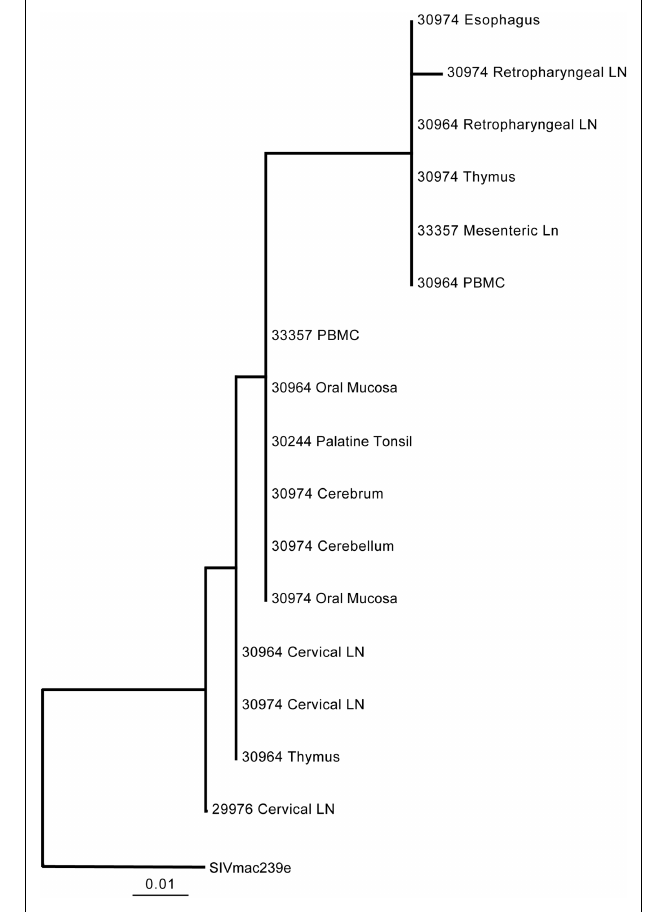
FIGURE 3 | Phylogenetic analysis of SIV EnvV1–V2 regions in lymphoid and non-lymphoid tissues following oral inoculation .The viral diversity within the first 7days post-oral transmission of SIV results indicates the SIV env V1–V2 sequences in the cerebrum and cerebellum are closely related to sequences found in other lymphoid